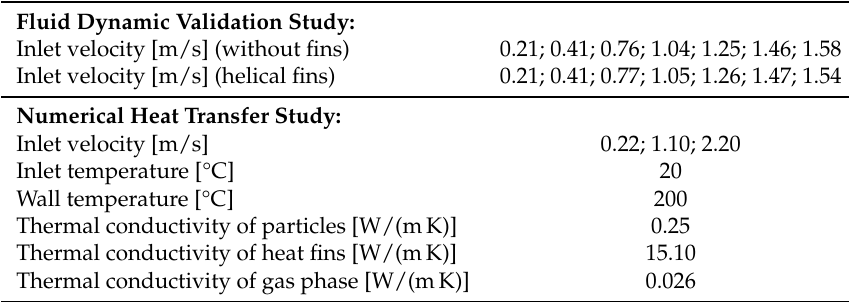
Figure 3. Visualization of the investigated reactor designs: Tube without heat fins ( A ), with straight heat fins ( B ), and with helical heat fins ( C ). Tube diameter = 25.4mm; particle diameter = 7mm; fin depth = 4.2mm; fin thickness = 1mm. Table 1. Properties and boundary conditions